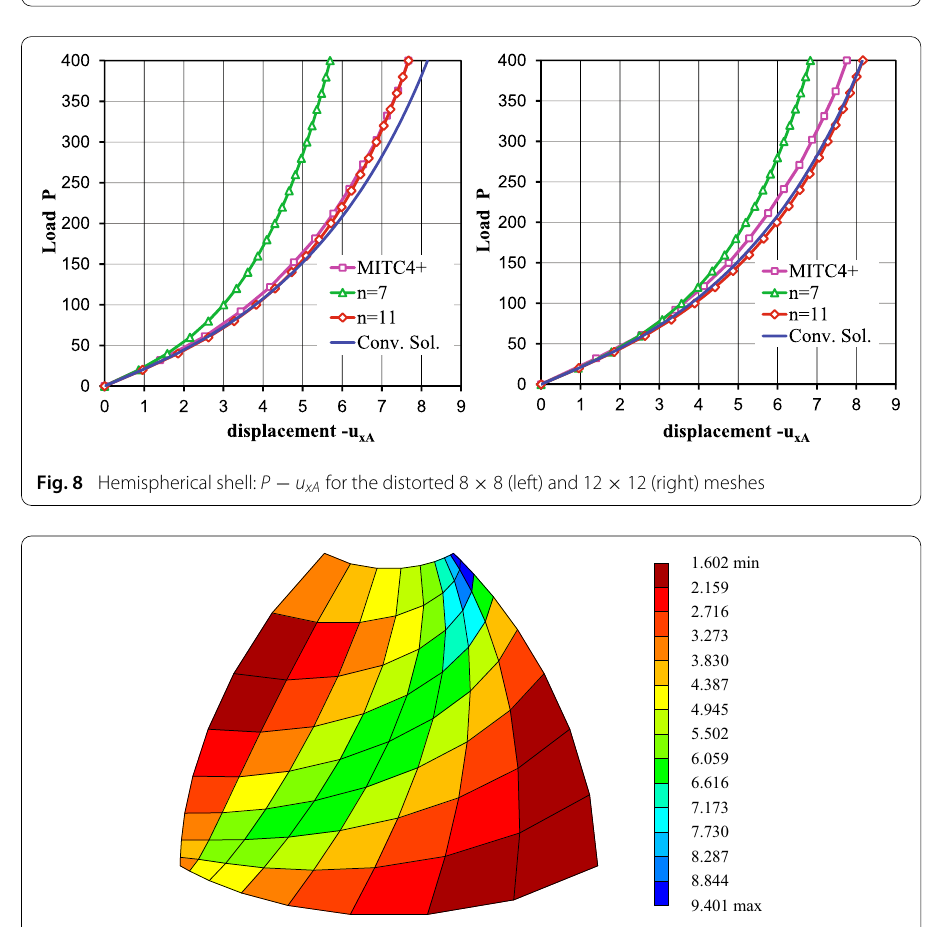
Fig. 9 Hemispherical shell: distribution of factor c for the distorted 8 × 8